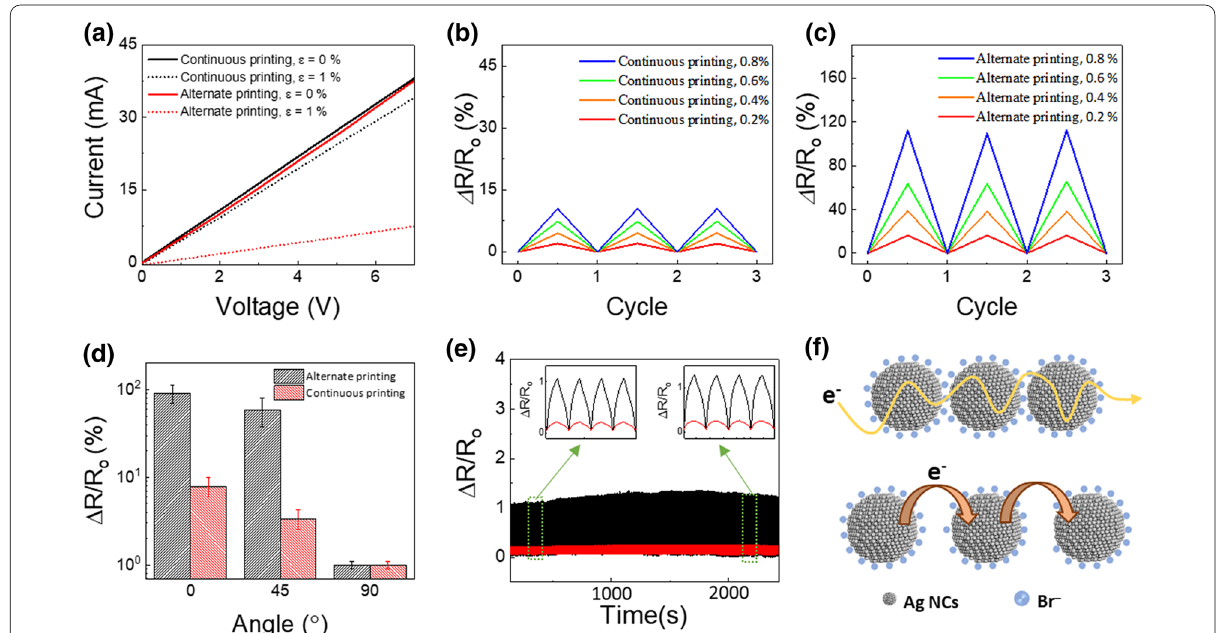
Fig. 3 Electrical and electromechanical properties of patterns coated on a 250 μm thick PET substrate. a Current–voltage plot of the Ag NC thin films with continuously and alternately printed patterns (solid black and red profiles, respectively) that were strained to 0% and 1% (solid and dot-dash lines, respectively). Changes in resistance of specimens with b continuously and c alternately printed patterns strained to 0.2% (red), 0.4% (orange), 0.6% (green), and 0.8% (blue). d Changes in resistance of specimens strained to 0.8% as a function of angular orientation (0°, 45°, and 90°). e Cycle test of specimens strained to 1%; insets show four-cycle properties of coupled (red) and periodic (black) Ag NC patterns. f Schematic illustration of electron movement mechanism in scenarios with different interparticle